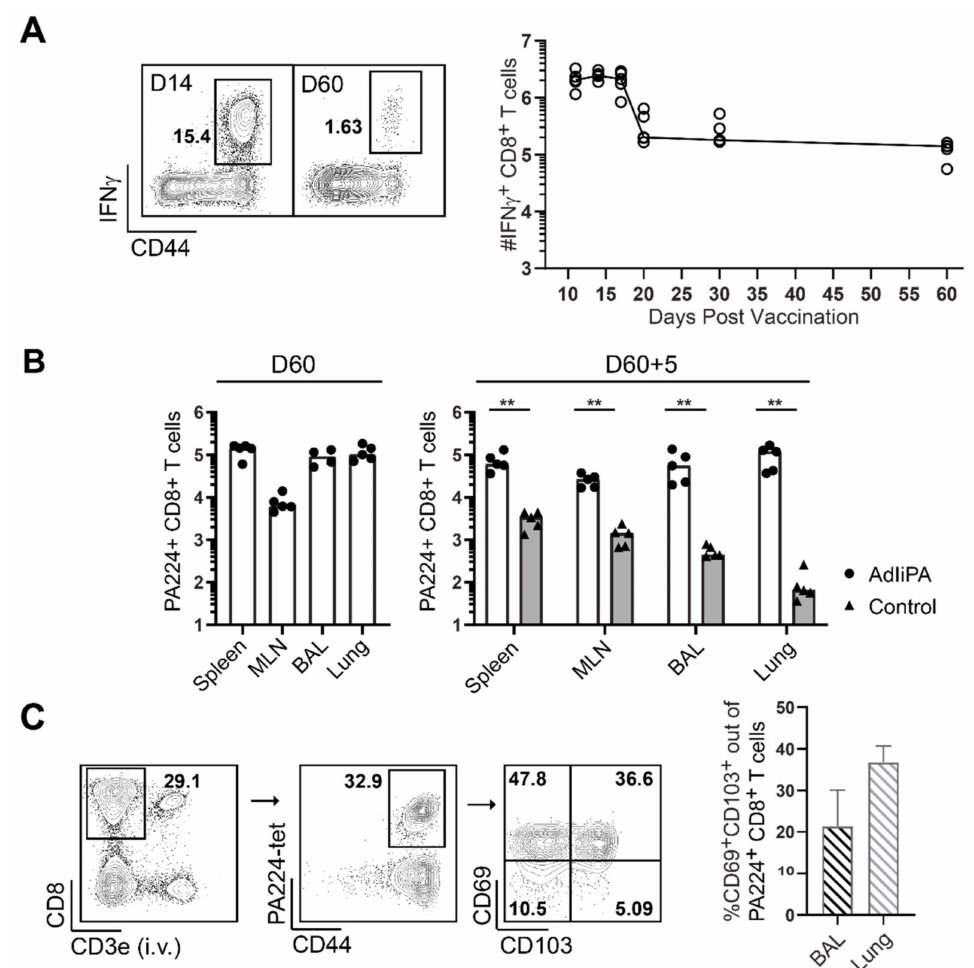
Figure 1. Kinetics of the CD8+ T-cell response to immunization with AdIiPA after priming and chal- lenge. ( A ) C57BL/6 mice were immunized intranasally (i.n.) and subcutaneously (s.c.) with AdIiPA, and spleens were isolated at indicated time points and stimulated with PA224 peptide, followed by ICCS. Samples were analyzed using flow cytometry and enumerated (right). Representative plots of CD8 T cells 14 and 60 days post-immunization (left). ( B ) D b -PA224 tetramer-specific CD8 T cells in spleen, mediastinal lymph node (MLN), brochoalveolar lavage (BAL), and lungs were analyzed 60 days after immunization or 5 days after i.n. influenza challenge carried out 60 days after immunization. Controls were naïve mice challenged with influenza. Bars represent mean, and each dot represents one individual mouse. ( C ) Representative plots (left) and percentage of tissue resident T cells (right) out of the PA-specific cells in the lungs and BAL 60 days after immunization with AdIiPA. N = 5 mice. Bars represents mean + SD. Graphs are representatives of experiments repeated three times with similar results. ** = p <